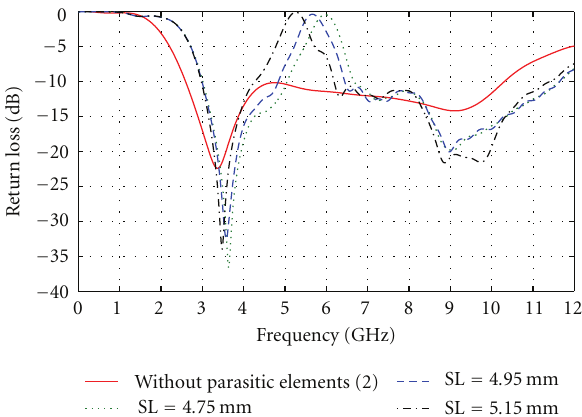
Figure 3: Simulated return losses due to height (SL) of a parasitic element (2).